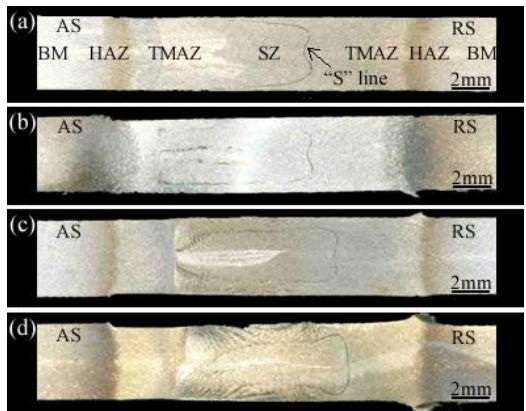
Figure 6. Cross-sections of BT-FSW joints welded for different rotational speeds: ( a ) 600 r/min, ( b ) 800 r/min, ( c ) 1000 r/min and ( d ) 1200 r/min. BM: base metal; HAZ: heat-affected zone; TMAZ: thermomechanically affected zone; SZ: stir zone.